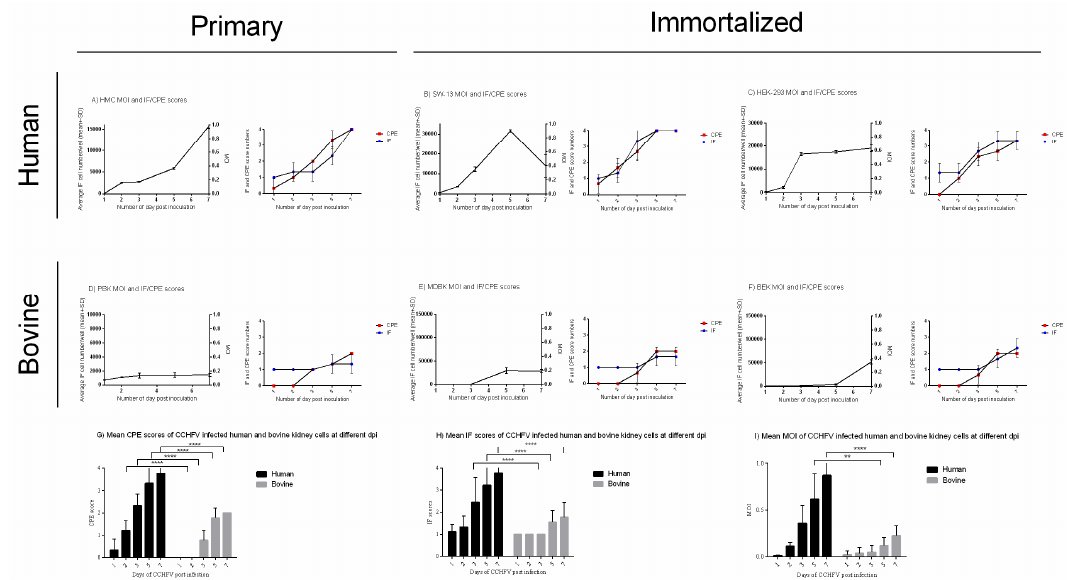
Figure 2. MOI, CPE, and IF staining scores of CCHFV infected human and bovine kidney cells in CCHFV infected cells on days one, two, three, five, and seven dpi. The CPE scoring system was based on assigning numbers (from zero to four) to various levels of CPE where zero indicates no visible change, one indicates CPE up to one-quarter (1%–25%), two up to half (26%–50%), three up to three-quarters, (51%–75%) and four up to all (76%–100%) cells of the monolayers. Uninoculated cells were used as negative controls. The mean percentage of positive cells with green fluorescence emission in 24-well plates measured in triplicates were used to calculate immunofluorescence scores. The grading was based on a one to four scoring system: one indicates up to one-quarter (1%–25%), two indicates up to half (26%–50%), three up to three-quarter (51%–75%) and four up to almost all (76%–100%) cells emitting fluorescence. Uninoculated cells were used as the negative control. The total cell number was counted by Cellcounter. MOI was counted by the following formula: average fluorescent cell/area × 20 area/well × dilution divided by cell number/well. Mean and SD were measured from triplicate measurements. MOI and CPE-IF scores display major differences between human and bovine cells with higher scores and levels in human cells in all indicated factors. ( A ) HMC MOI, CPE, and IF scores; ( B ) SW-13 MOI, CPE, and IF scores; ( C ) HEK-293 MOI, CPE, and IF scores; ( D ) PBK MOI, CPE, and IF scores; ( E ) MDBK MOI, CPE, and IF scores; ( F ) BEK MOI, CPE, and IF scores. Differences in the mean of three human and the mean of three bovine kidney cells MOI, CPE, and IF scores. ( G ) Mean human and bovine kidney cells CPE scores; ( H ) mean human and bovine kidney cells IF scores; ( I ) mean human and bovine kidney cells MOI scores. The mean and SD were based on triplicate measurements. ** p -value ≤ 0.01, **** p -value ≤ 0.0001. Viral proteins were detected by IIFA in all infected cell lines from the first day after virus